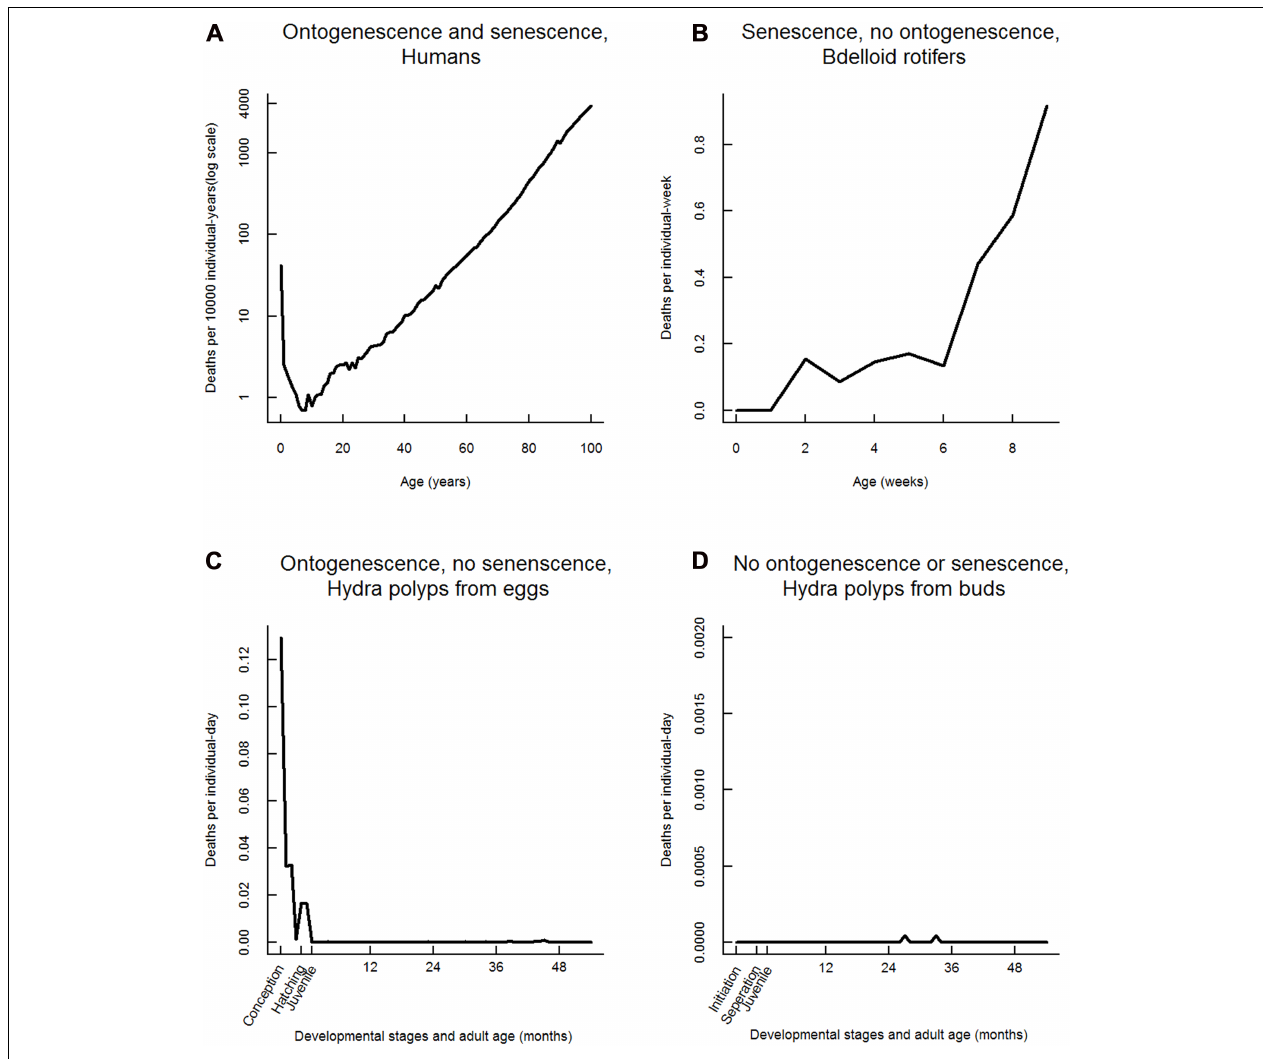
but this pattern is seen repeatedly across trials and bdelloid species. (C) Hydra of strain AEP developing in and hatching from eggs suffer intense ontogenescence (159/344 pre-adults died, meaning 46% mortality between egg formation and reproductive maturity), but do not senesce. (D) Hydra of the same strain, under the same conditions, but developing as buds rather than eggs, experience no age-related mortality (0/122 pre-adults died) as juveniles or